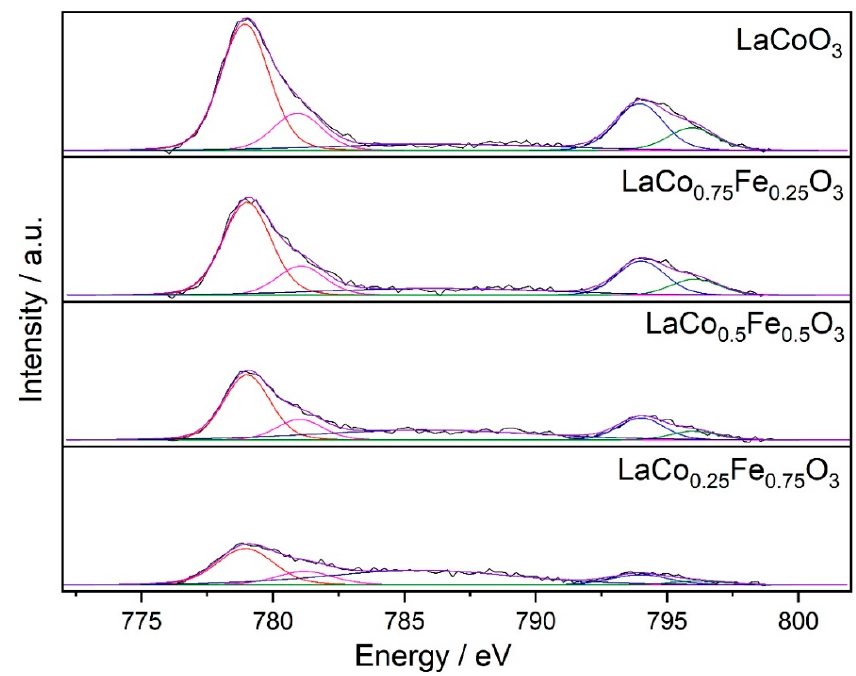
Figure 6. XPS spectra of Co2p.